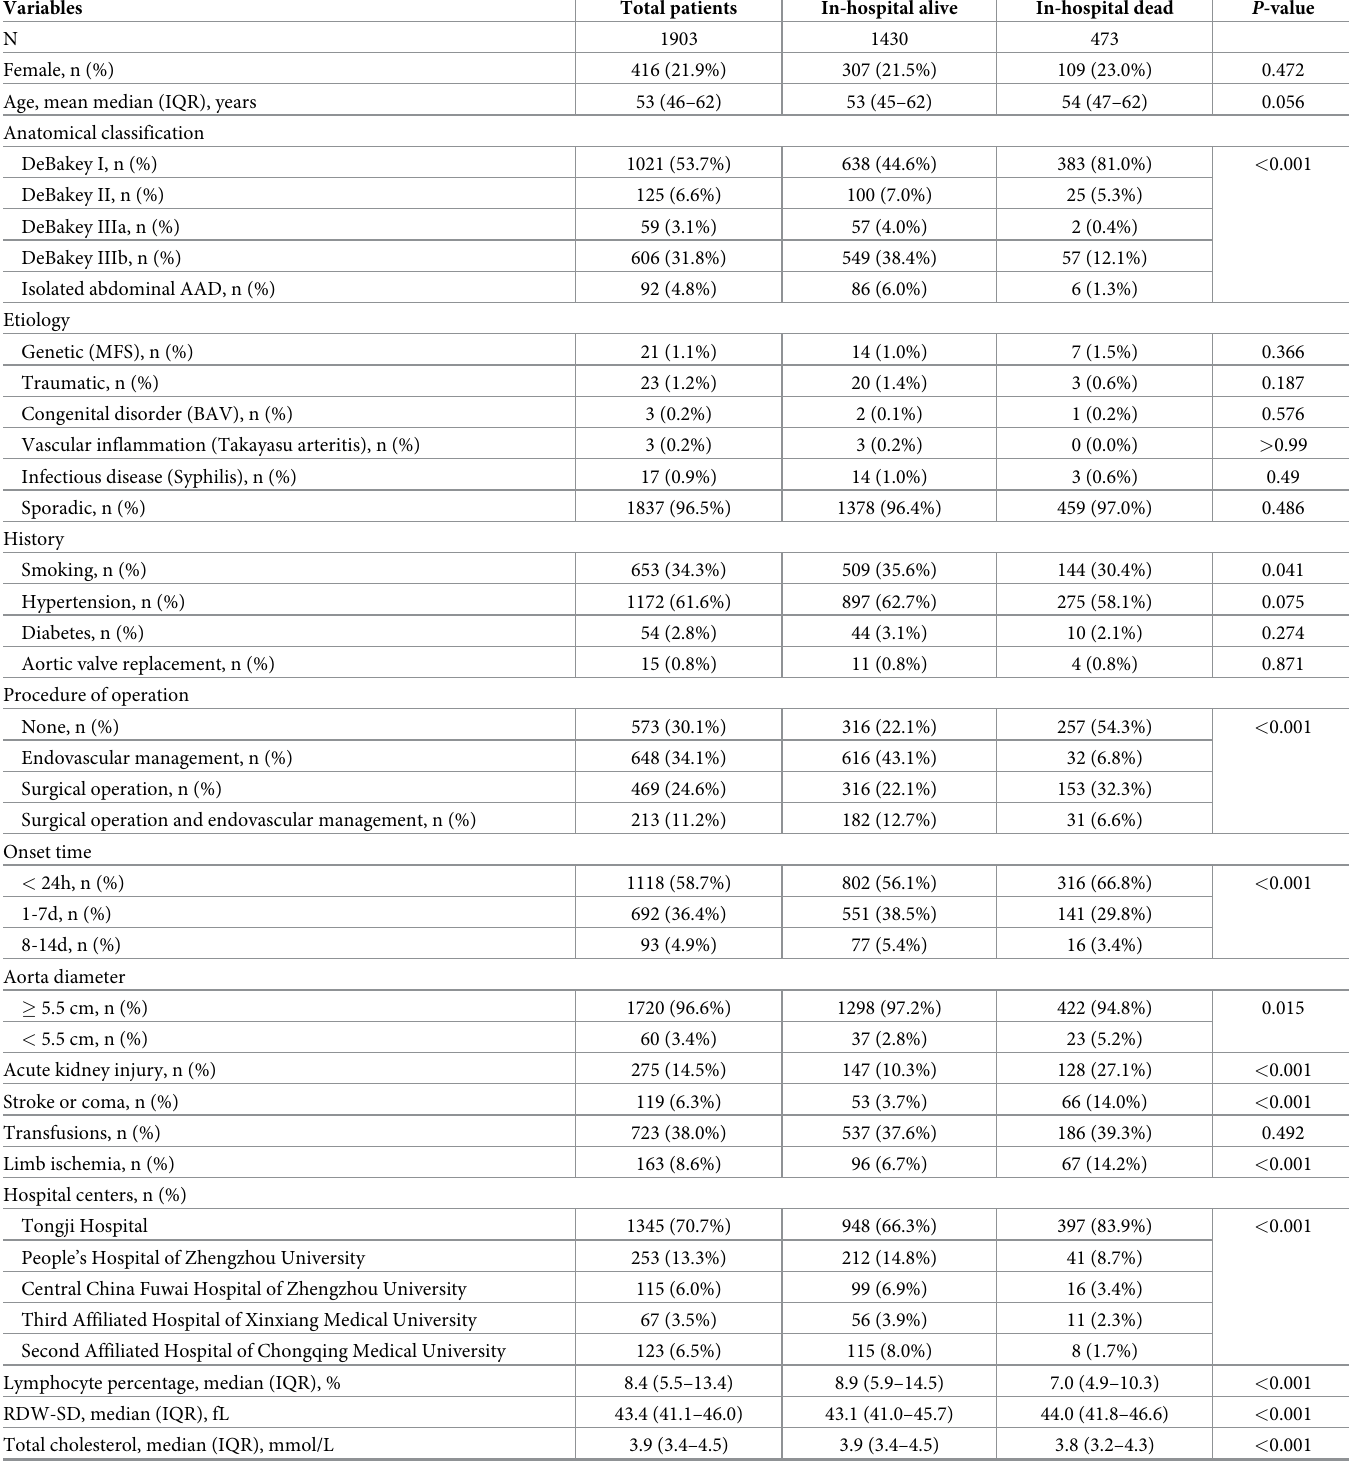
Table 1. Patient baseline